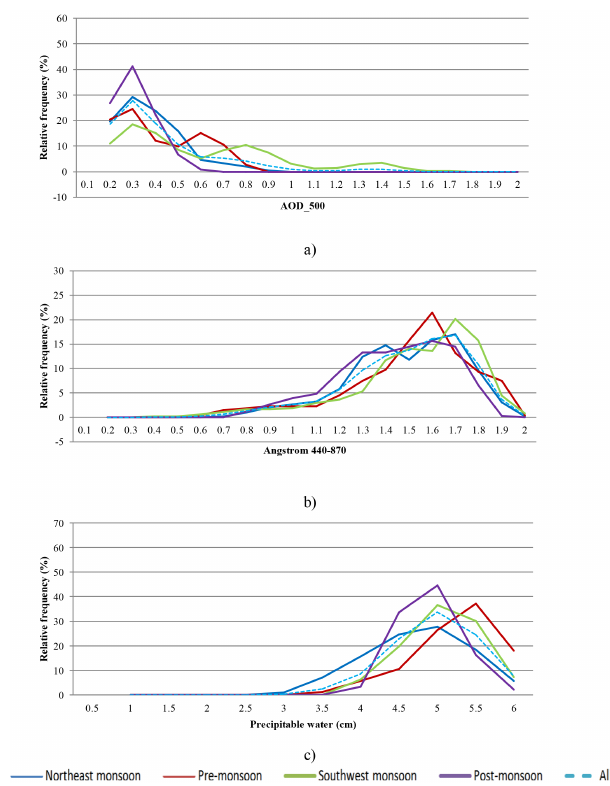
Figure 1. Seasonal relative frequencies of occurrences of (a) AOD_500, (b) Ångström 440 − 870 , and (c) PW in Penang for Febru- ary 2012 to November 2013. Each curve was smoothed by using a moving average